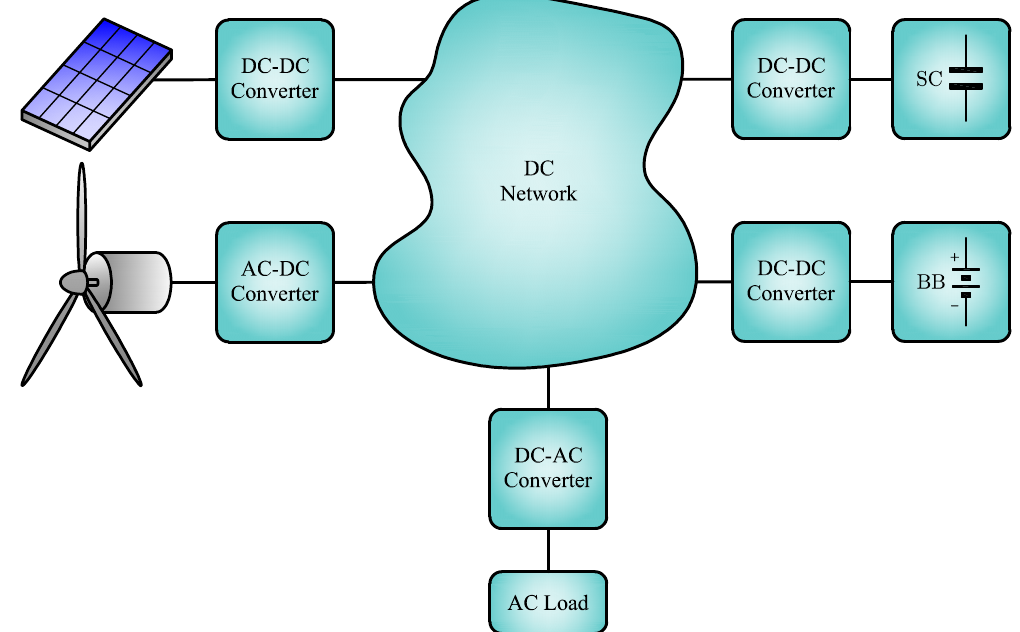
Figure 1. Renewable-based hybrid DC